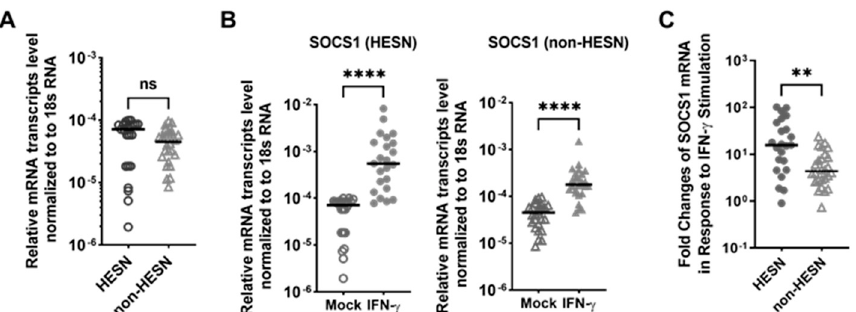
Figure 5. Expression of SOCS1 mRNA in HESN and non-HESN PBMC. Relative levels of SOCS1 RNA transcripts in HESN and non-HESN PBMC were evaluated ( A ) before and ( B ) 3 h after IFN- γ stimula- tion (10 ng/mL). Levels of SOCS1 transcripts were normalized to 18S rRNA levels. ( C ) Fold changes in SOCS1 transcript levels, included by IFN- γ were calculated. t -tests were used to compare the differences between the two groups. Median values ( - ) were shown for each group. ** p -value < 0.01, **** p -value < 0.0001; n.s. denotes ‘not statistically